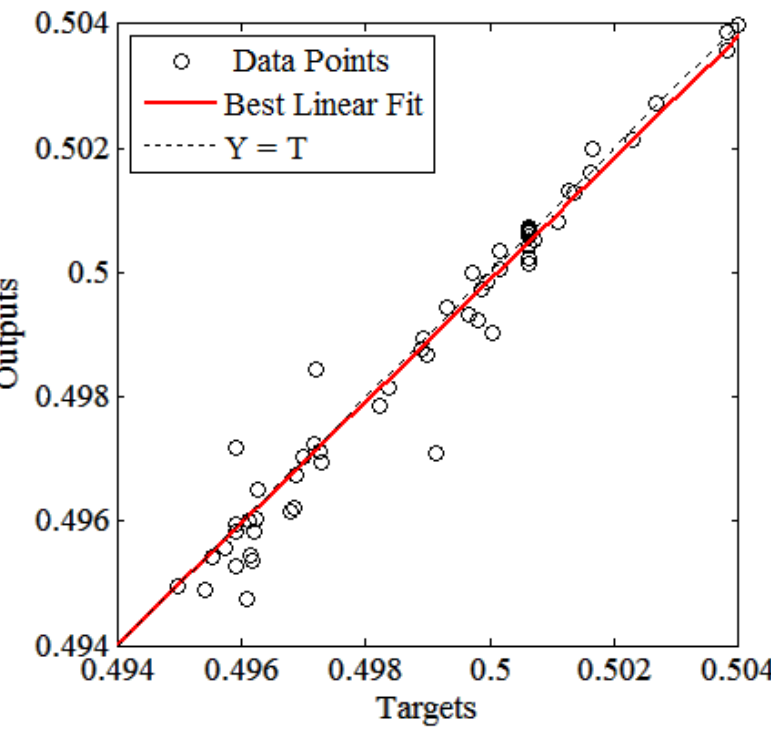
Figure 11. ANN performances.